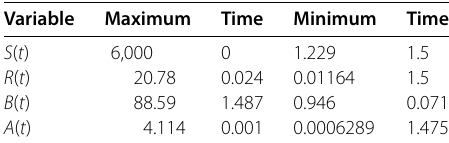
Table 8 Extremum values of the realizations Variable